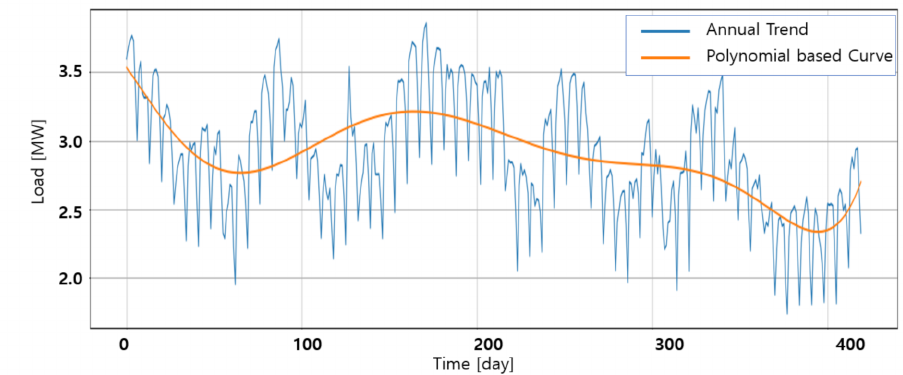
Figure 6. Example of the annual load patterns and the polynomial based